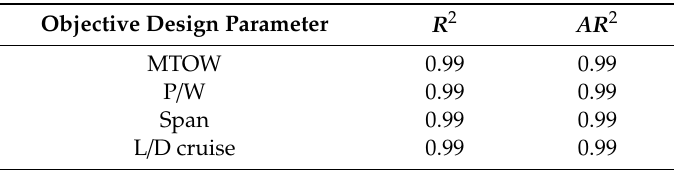
Table 16. R 2 , AR 2 of response surface